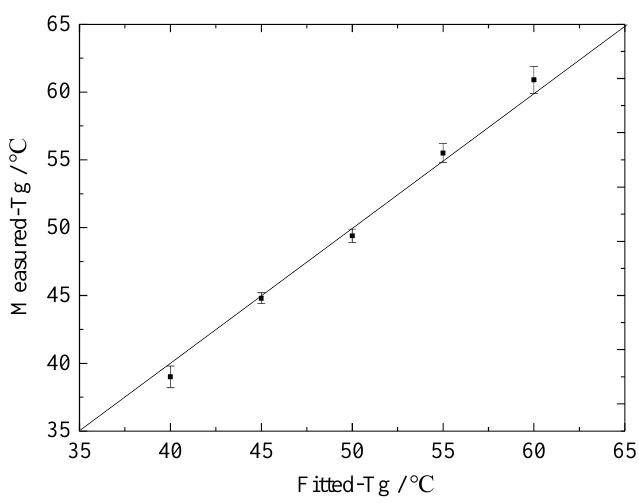
Figure 7. 45 degrees contour map of the SM-HEP T g .